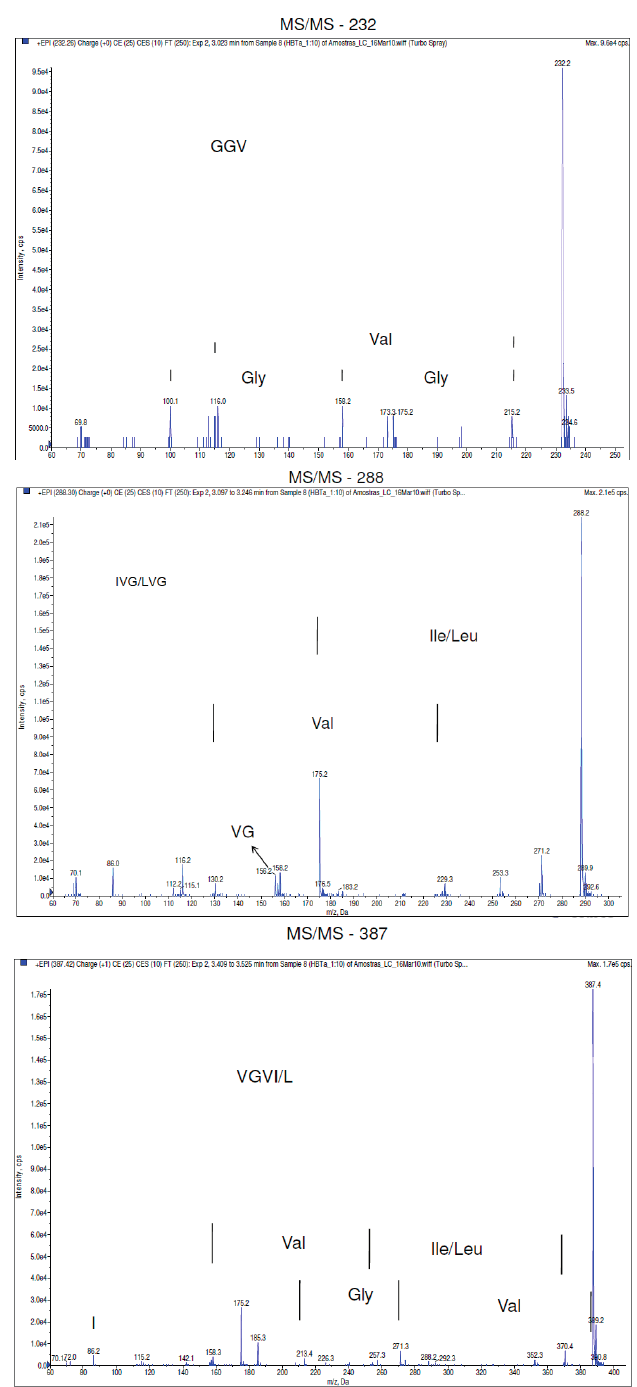
Figure 2. Mass spectrum of the selected chromatographic peaks ( m / z 232, m / z 288, and m / z 387). The peptide ( m / z 232) was identified as the sequence GGV. To the peptide ( m / z 288) it was assigned the sequences IVG or LVG. The differentiation between L and I was not possible because of their identical masses. The tetrapeptide ( m / z 387) was identified as VGVI or VGVL. Again, the differentiation between L and I was not possible because of their identical